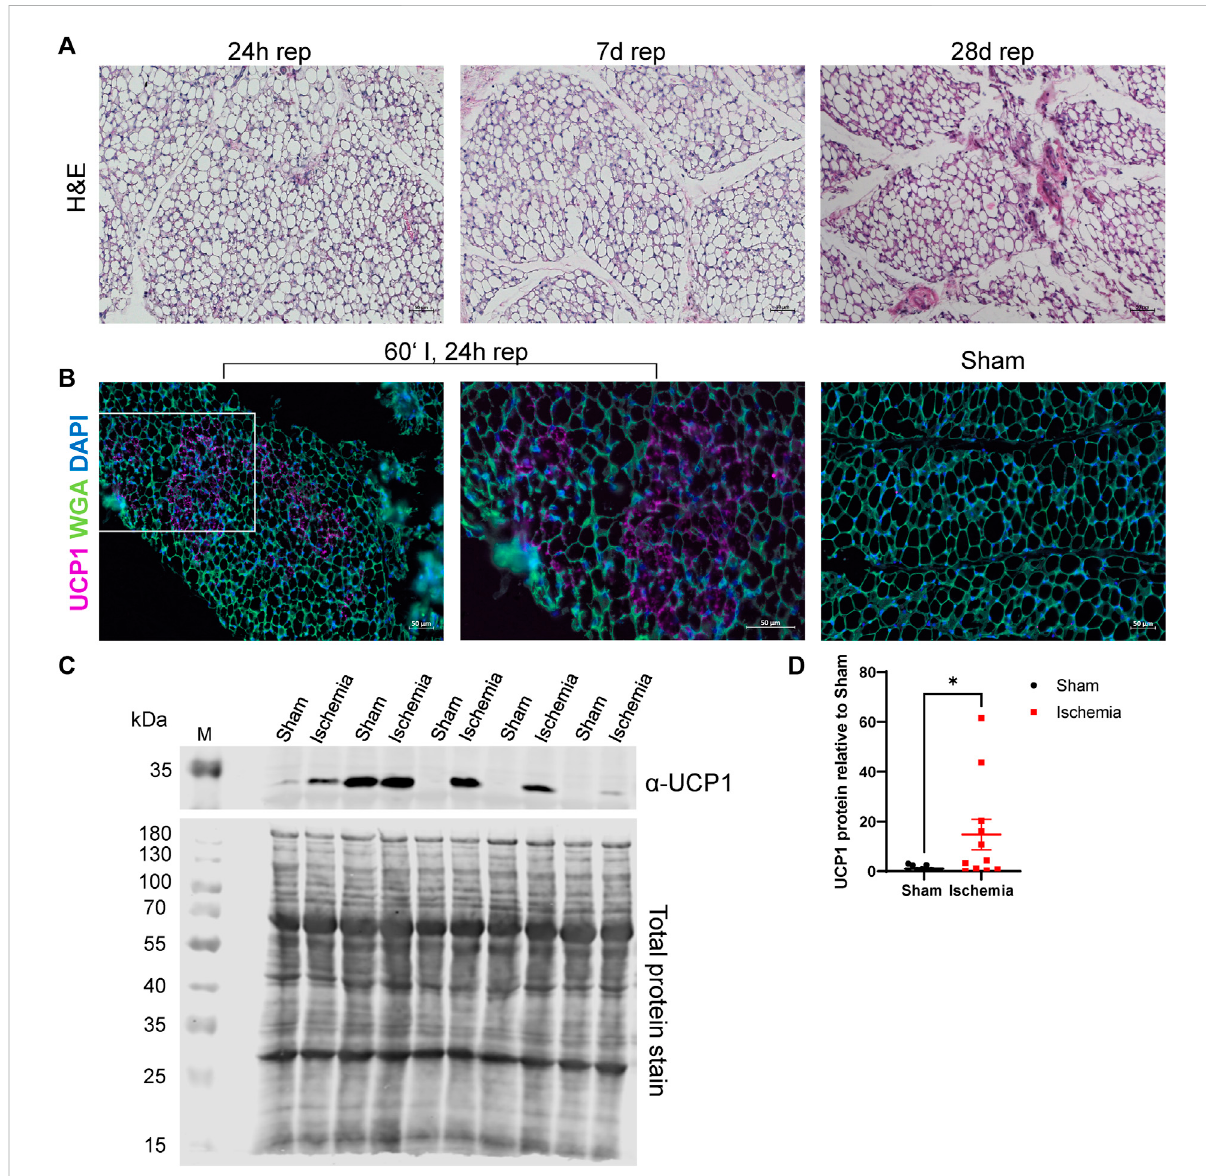
FIGURE 3 Cardiac I/R induces a brown-like phenotype in iWAT (A) H&E staining of iWAT after 60 ′ ischemia and 24h, 7 days or 28 days of reperfusion. (B) Immuno fl uorescencestainingagainst UCP1iniWATof60 ‘ ischemiaand24 hreperfusion,20x (leftpanel)and 40x(middlepanel) magni fi cations and of Sham/24 h reperfusion (right panel). UCP1: purple, WGA: green, DAPI: blue (C) Western blot analysis of UCP1 expression in iWAT after 24 h of reperfusion with corresponding total protein stain of this membrane used for normalization. Uncropped images of these blots are displayed in SupplementaryFigureS4. (D) Quanti fi cationofproteinexpressionofUCP1relativetoSham, n =13,dataaremean±SEM,ROUTtest(Q=1)identi fi ed 3 statistical outliers in the “ Sham ” -group and 2 in the “ Ischemia ” -group which were excluded, Mann-Whitney test was used for statistical analysis, * p <